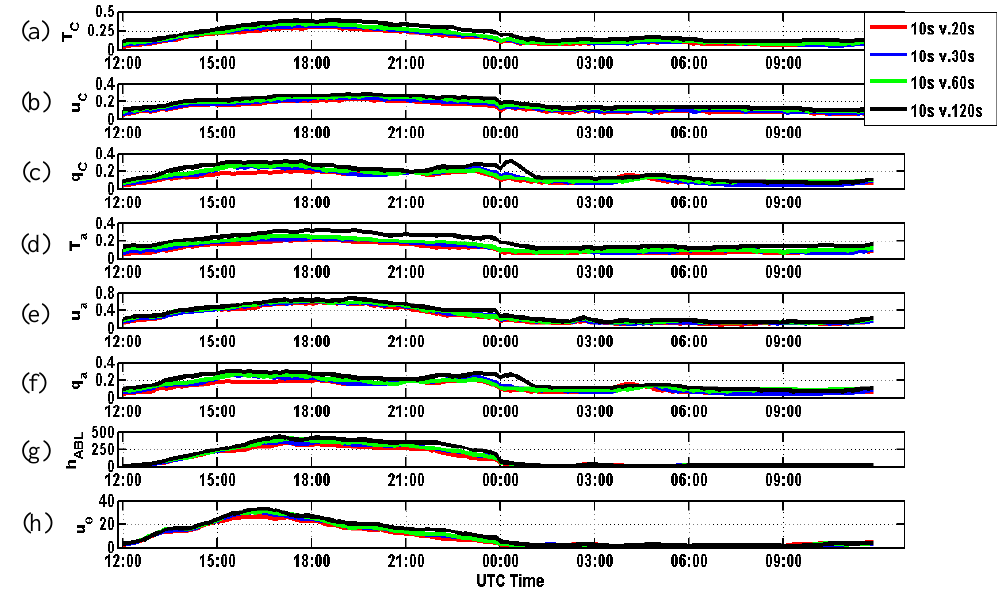
Fig. 12. RMSD of selected meteorological quantities over the fourth model grid for comparison of case 10s and others of differing land cover resolution (in arc-seconds), averaged over all available data in Period 1 and Period 2. RMSD is shown versus time of day (UTC time) in units of K for (a) canyon temperature ( T c ), ms − 1 for (b) canyon wind speed ( u c ) and gkg − 1 for (c) canyon water vapor mixing ratio ( q c ), K for (d) lowest model layer ( ∼ 28ma.g.l.) temperature (Ta), ms − 1 for (e) lowest model layer wind speed ( u a ), gkg − 1 for (f) lowest model layer water vapor mixing ratio ( q a ), m for (g) boundary layer depth (hABL) and degrees for (h) lowest model layer wind direction ( u θ